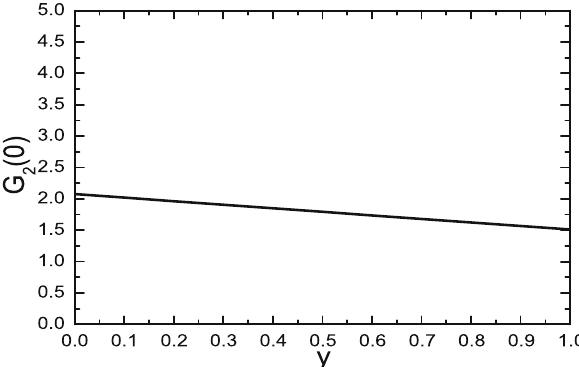
Fig. 4 The form-factor G 2 ( 0 ) with variation of the parameter y = − κ( 1GeV ) = ξ( 1GeV )/ 2